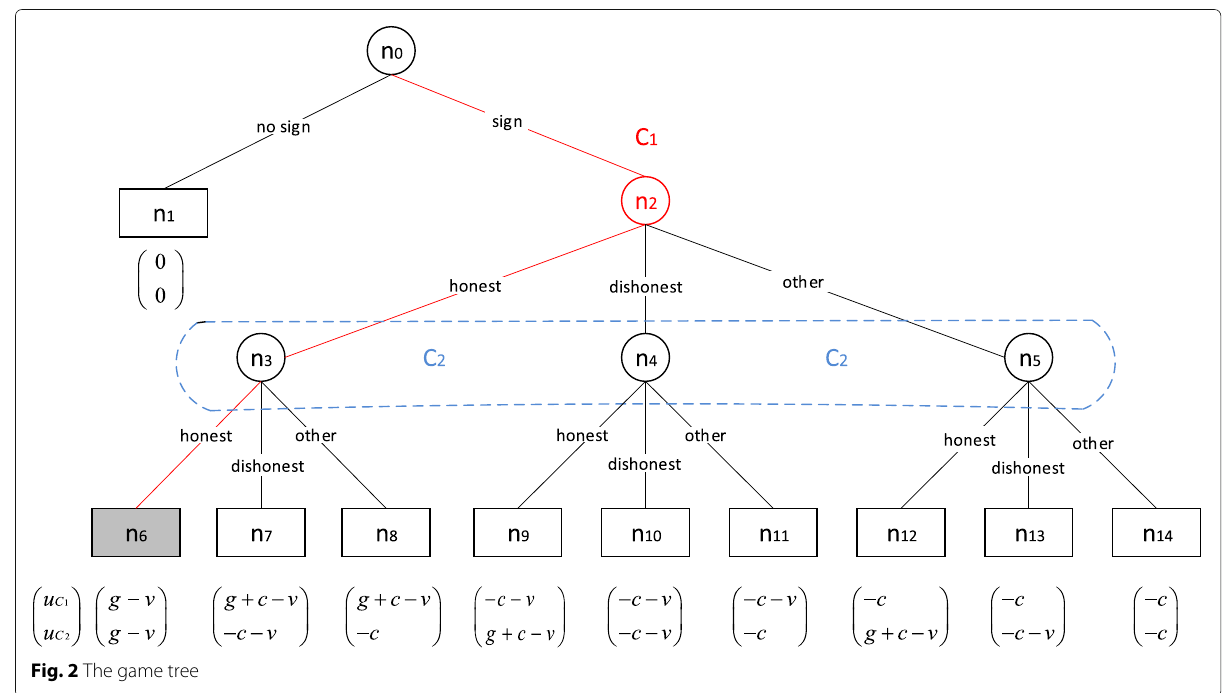
Fig. 2 The game tree